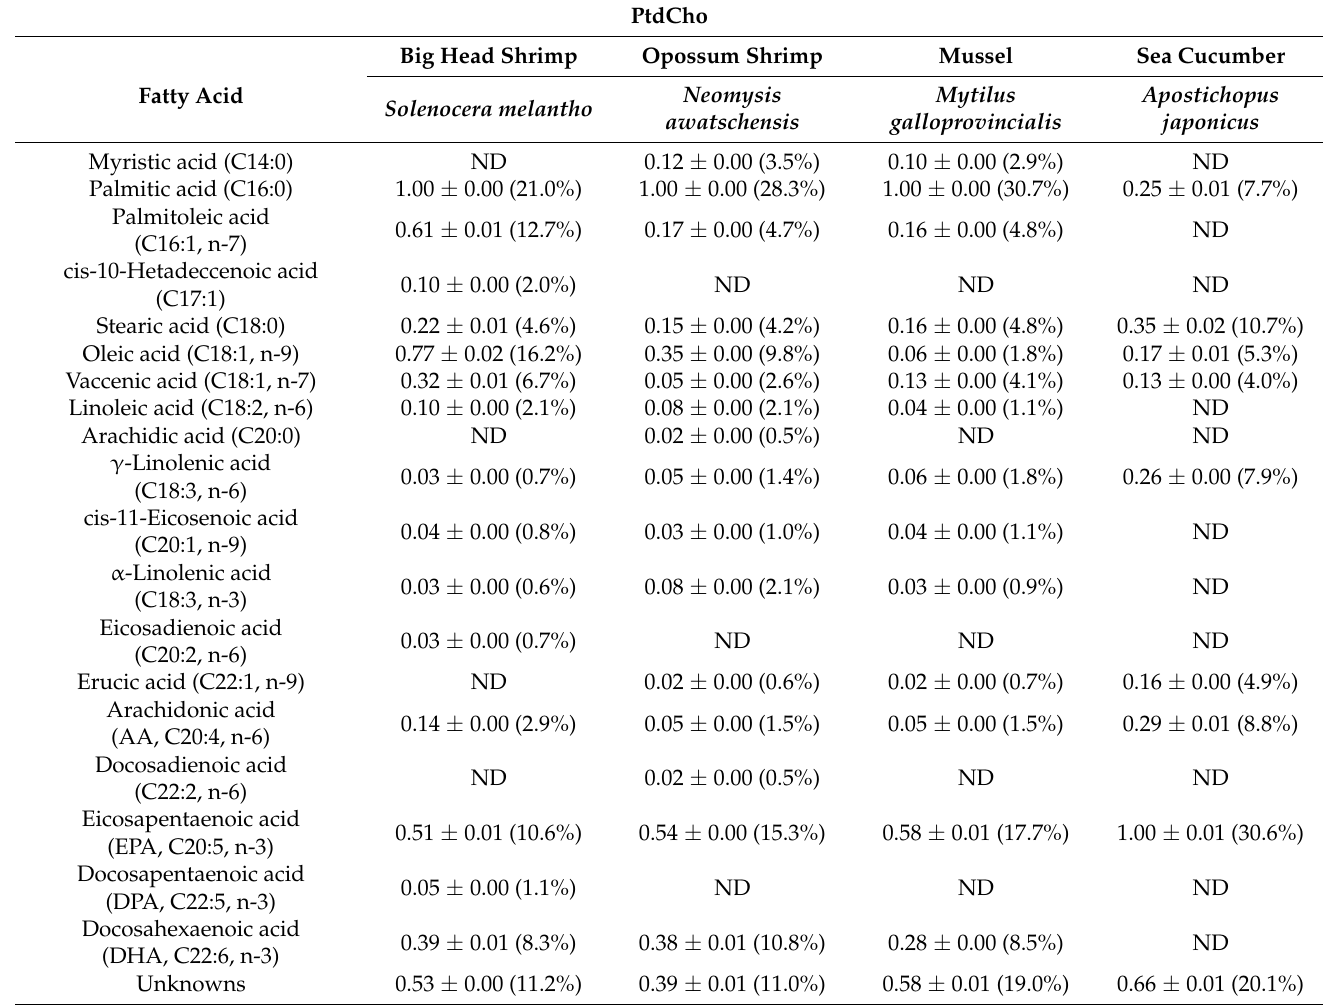
Table 4. Fatty acid composition (area %) and relative index of phosphatidylcholine in the extracted lipids from the dried big head shrimp, opossum shrimp, mussel, and sea cucumber. Relative index = value of each fatty acid area/value of the largest known fatty acid area.